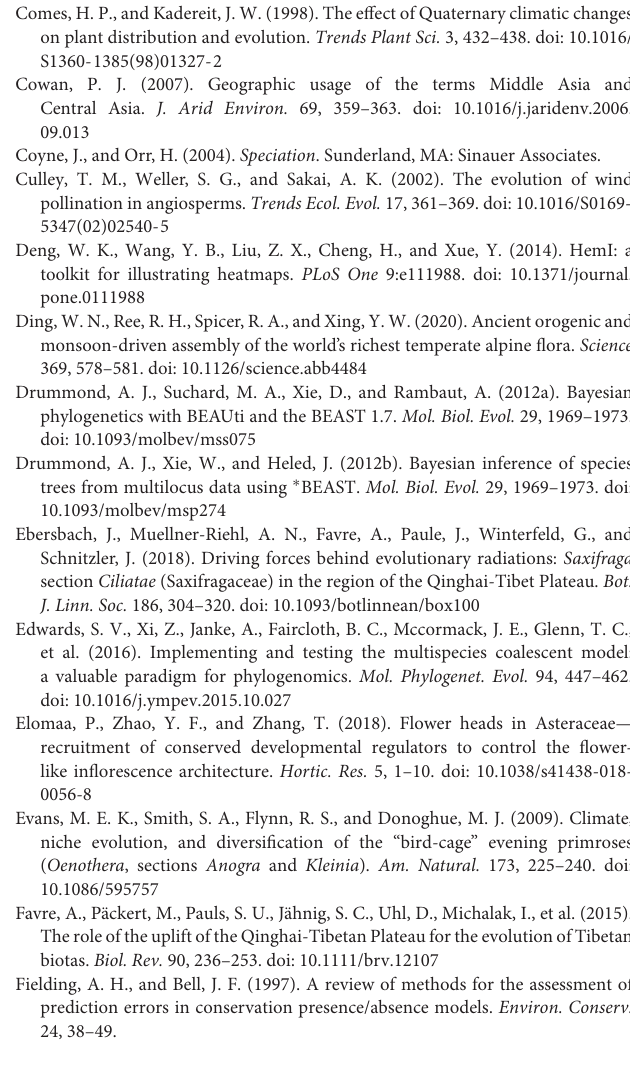
Supplementary Figure 5 | Potential suitability distribution of climate conditions of major lineages within the Chrysanthemum -group. Supplementary Figure 6 | Ancestral state reconstruction of capitulum architectures based on the phylogenetic framework under likelihood model (right) and continuous-time Markov model (left) . Supplementary Figure 7 | Comparison of the gene tree of CYC2g that regulates capitulum architectures in subtribe Artemisiinae and the present multilocus phylogeny (left, redrawn from Figures 1 , 2 in the main text). Supplementary Table 1 | Species used in the present study and the sampling information. Supplementary Table 2 | GPS coordinates used for niche modeling in this study. Supplementary Table 3 | Biogeographic history of subtribe Artemisiinae reconstructed with DEC and s-DEC. Supplementary Table 4 | Pairwise niche overlap among three subclades of the Chrysanthemum -group under predicted niche occupancy profiles (PNO). Supplementary Data Sheet 1 | Datasets of the sequence